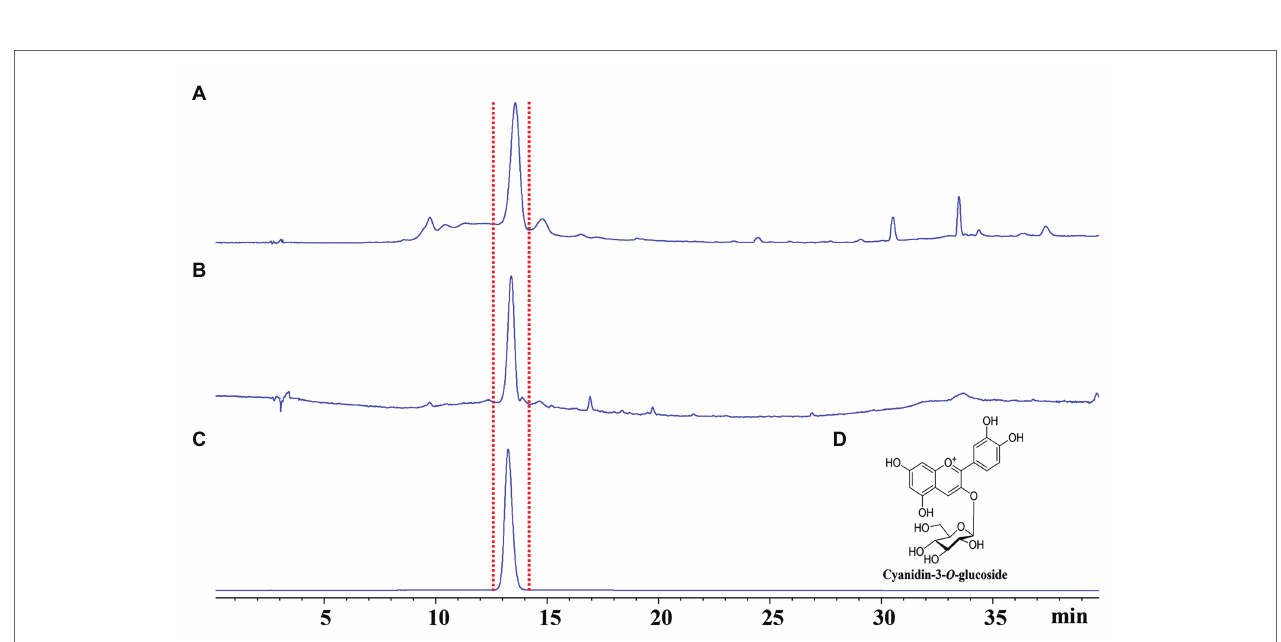
FIGURE 3 | Qualitative analyses of fresh gall tissues at stage G4 and cones of Picea koraiensis at stage F2 using HPLC-DAD at 520 nm. (A) HPLC analysis of gall tissues at stage G4; (B) HPLC analysis of cones of Picea koraiensis at stage F2; (C) HPLC analysis of cyanidin-3- O -glucoside (100 μ g/ml); and (D) Chemical structures of cyanidin-3- O